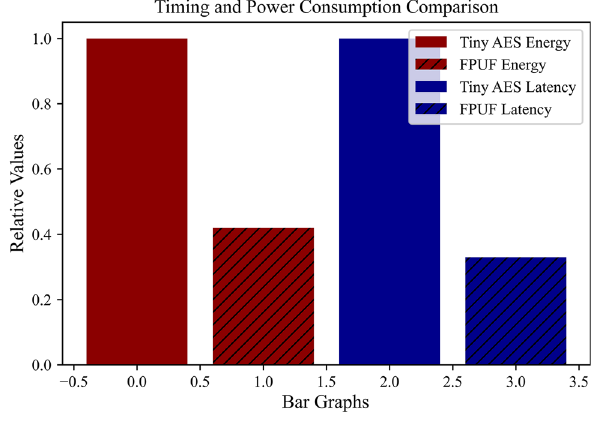
Fig. 12 Relative power consumption and latency comparison between the FPUF and traditional tiny AES encryption scheme